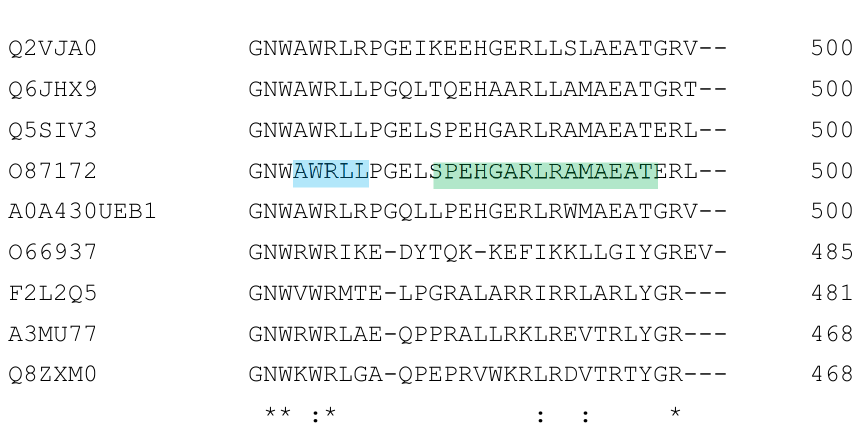
Figure 3. Multialignment of amylomaltases from thermophilic and hyper-thermophilic Bacteria and Archaea . Sequences of enzymes are indicated by their UniProt accession number (see Table 1). The order of the sequences and amino acids conservation symbols are as obtained by the Clustal program [54] (in particular, asterisks indicate identical residues; colons and dots indicate conserved and semi-conserved substitutions, respectively). The first eight sequences are from Bacteria ; the other three sequences belong to Archaea . The secondary structure description is related to amylomaltase from T. thermophilus (O87172) according to the 3D structure described by Przylas et al. [51]. In particular, green regions refer to the ( β / α ) 8 TIM barrel (domain A); the other coloured regions correspond to subdomain B2 (yellow), subdomain B1 (orange) and subdomain B3 (cyan). Conserved amino acids discussed in the main text are reported in bold, with the exception of the three catalytic amino acids, which are reported in red.